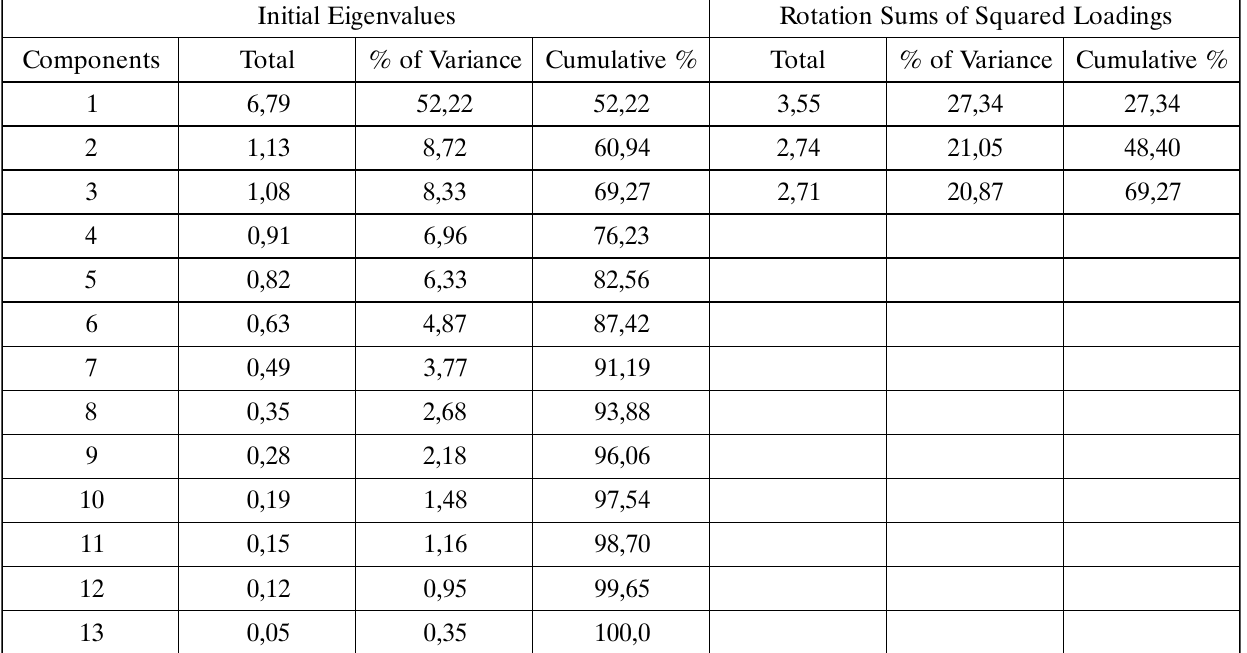
Table 7a . Factor Analysis – Innovation Difficulties